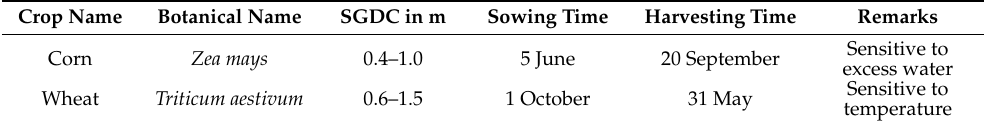
Table 3. Characteristics of two